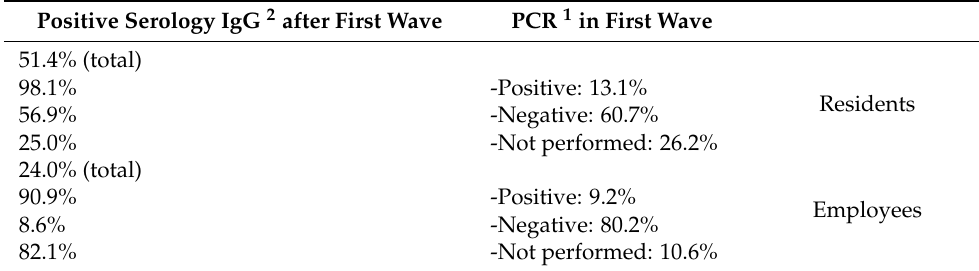
Table 1. Diagnostic tests for coronavirus in the first